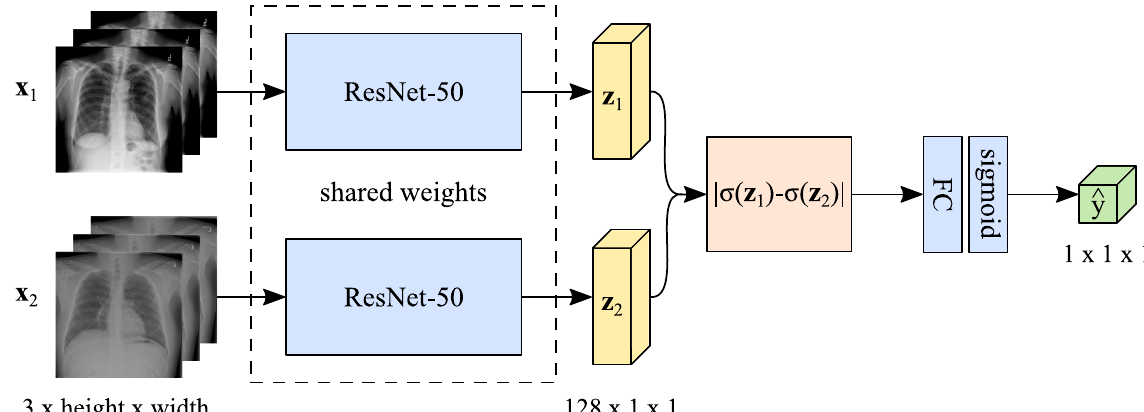
Figure 8. SNN architecture used for patient verification on the ChestX-ray14 16 dataset. The feature extraction blocks (light blue) share the same set of network parameters and produce the feature representations z 1 and z 2 (yellow). After merging (orange) and an additional FC and sigmoid layer σ (light blue), the network yields the final output score ˆ y (green). For our patient re-identification experiments, we used the same architecture but ejected all the layers from the merging layer